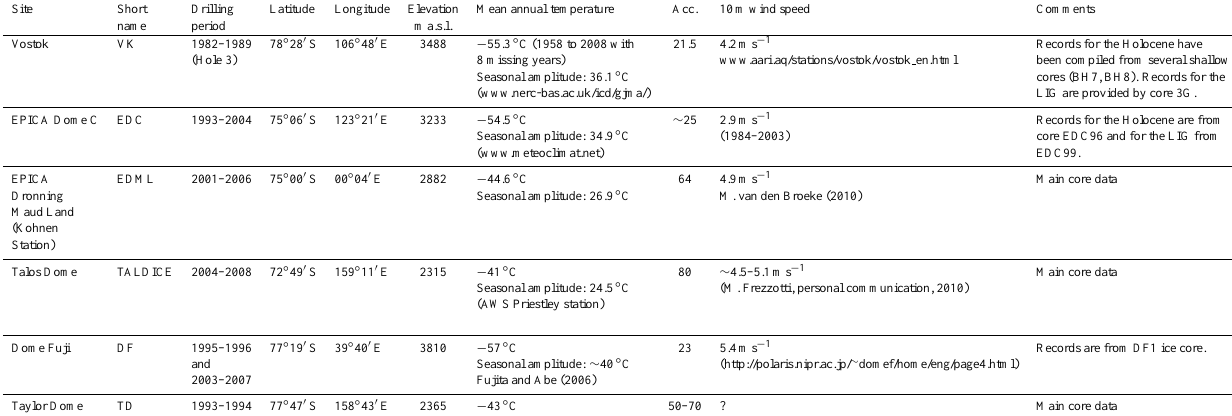
Table 1. Site characteristics. Accumulation (Acc.) is given in mm water equivalent per year (equivalent to 1kgm − 2 yr − 1 ).